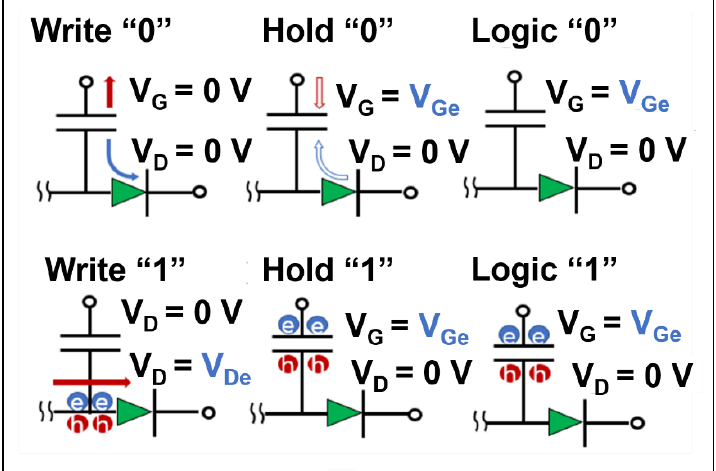
Figure 11. Diagram of a capacitor-less DRAM equivalent circuit with logic values “0” and “1” in three states: writing, holding, and reading (logic). The arrow line at Hold “0” corresponds to the leakage current of the reverse-biased drain junction limiting the hold time